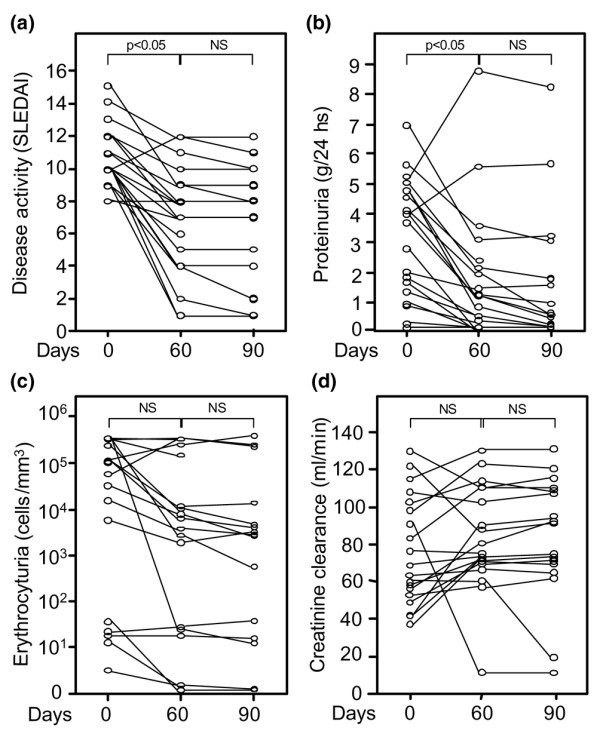
Effect of Rituximab therapy on different laboratory and clinical parameters in patients with systemic lupus erythematosus. Twenty-two systemic lupus erythematosus patients with active disease and renal involvement received Rituximab (0.5 to 1.0 g at days 0 and 15), and the (a) disease activity (MEX-SLEDAI index), (b) 24 hour proteinuria, (c) erythrocyturia, and (d) creatinine clearance were measured at days 0, 60, and 90.